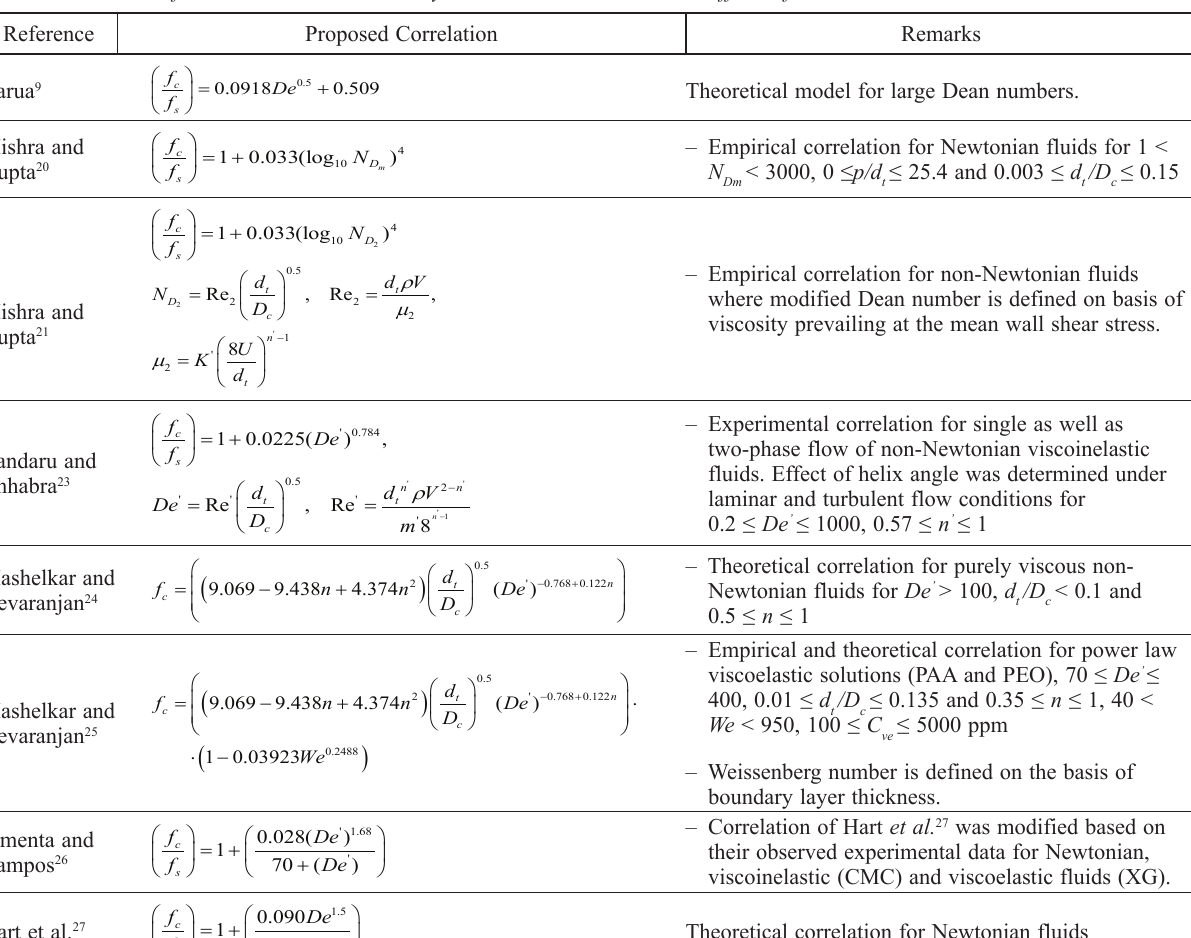
Bandaru and Chhabra 23